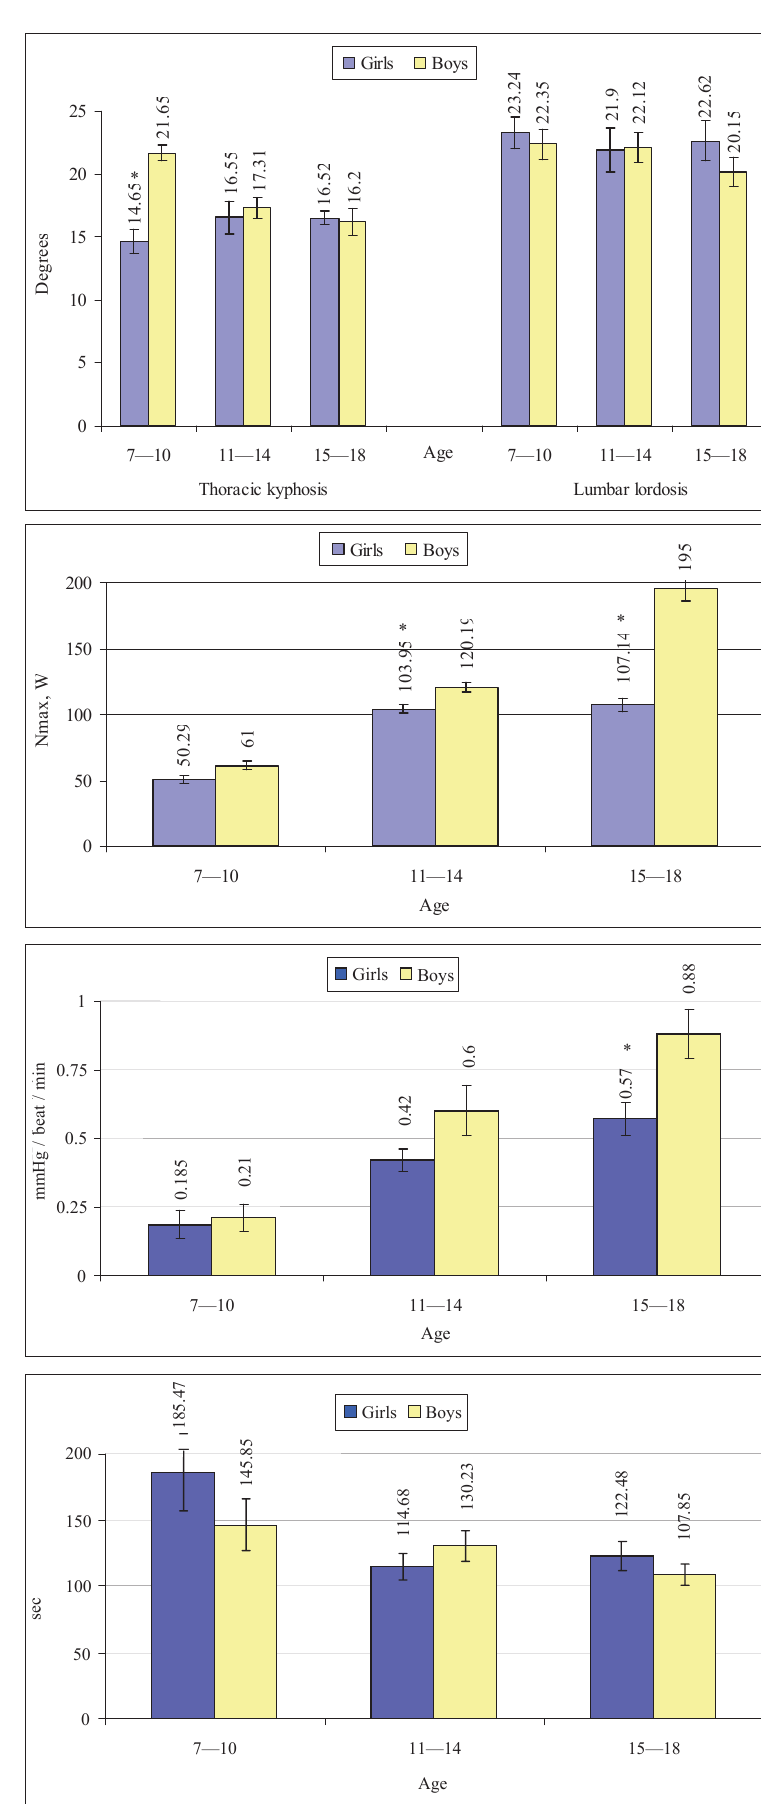
Figure 5. Changes of half recovery peri- od of systolic blood pressure (T rec S ½) with age among boys and